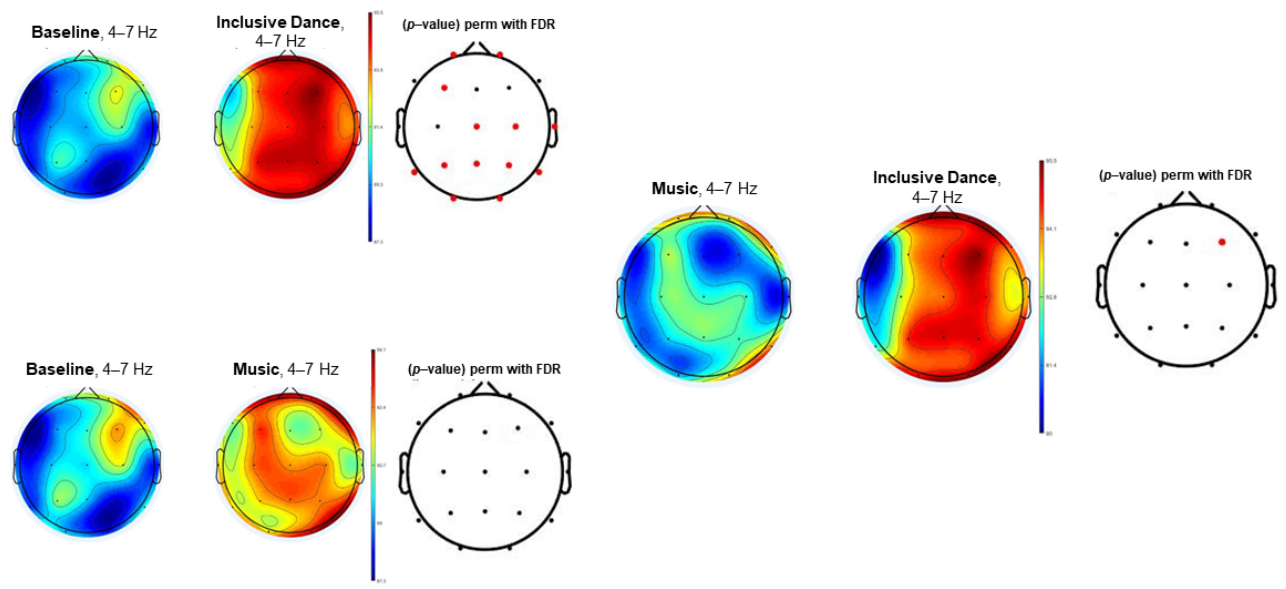
Figure 1. EEG topographic maps in the theta power spectrum (4–7 Hz) of the comparison between baseline, inclusive dance, and listening to music conditions. Significant comparisons ( p -value < 0.05) have been highlighted in red.